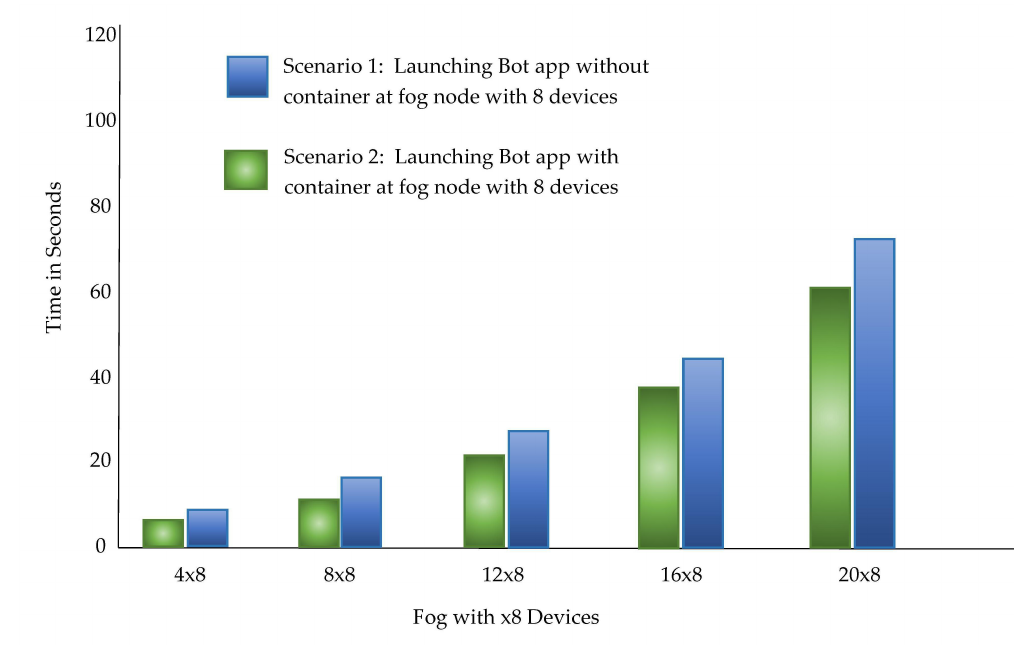
Figure 18. Time taken to place microservice in fog node with eight devices.